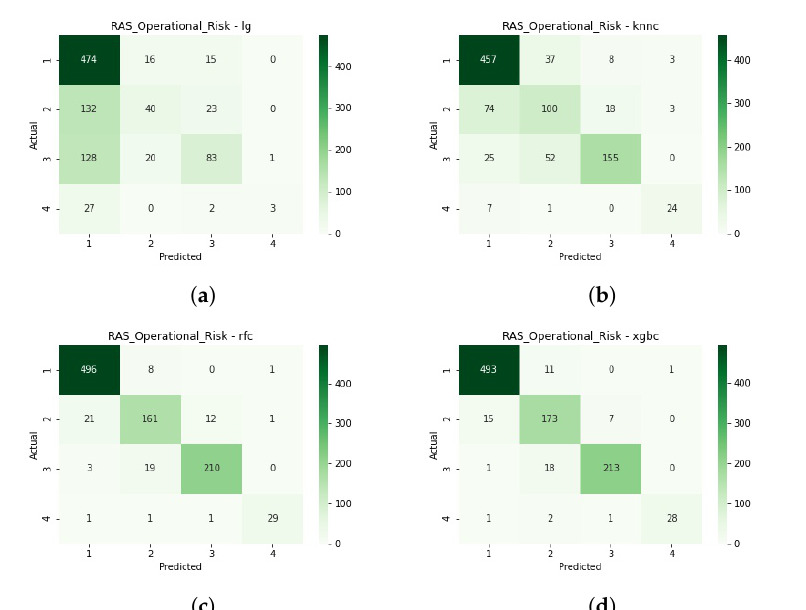
Figure A5. Operational risk: confusion matrices generated when evaluating the above-mentioned models, using train-test split approach. ( a ) Logistic Regression. ( b ) k-Nearest Neighbours classifier. ( c ) Random Forest classifier. ( d ) Extreme Gradient Boosting classifier.